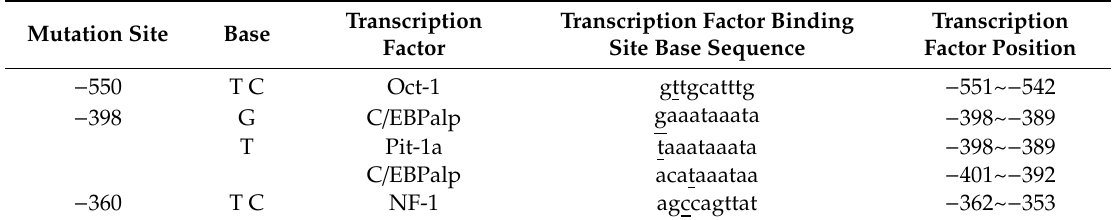
Table 2. Prediction results for transcription factor changes before and after single nucleotide polymorphisms (SNP) mutations in the 5’ regulation region of the IL-8 gene.